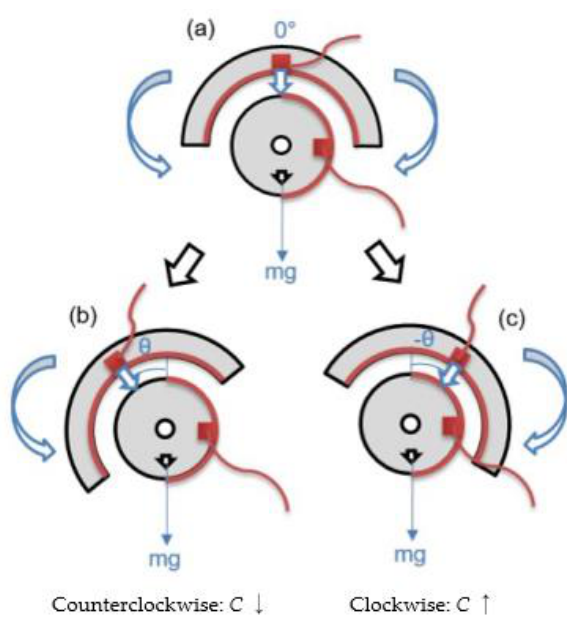
Figure 4. ( a ) The null position of the capacitive tilt sensor, and when it is rotated ( b ) counterclockwise and ( c ) clockwise, are shown.